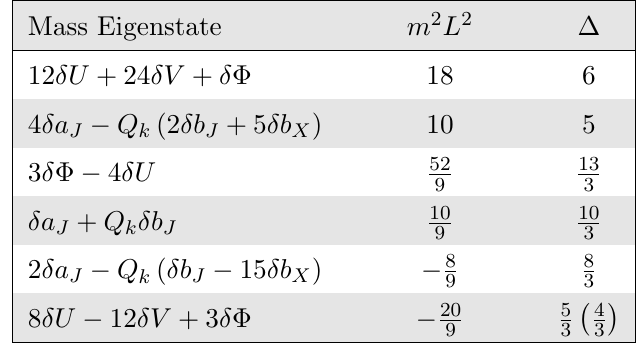
Table 1 . Spectrum of scalars around the N = 1 supersymmetric AdS 4